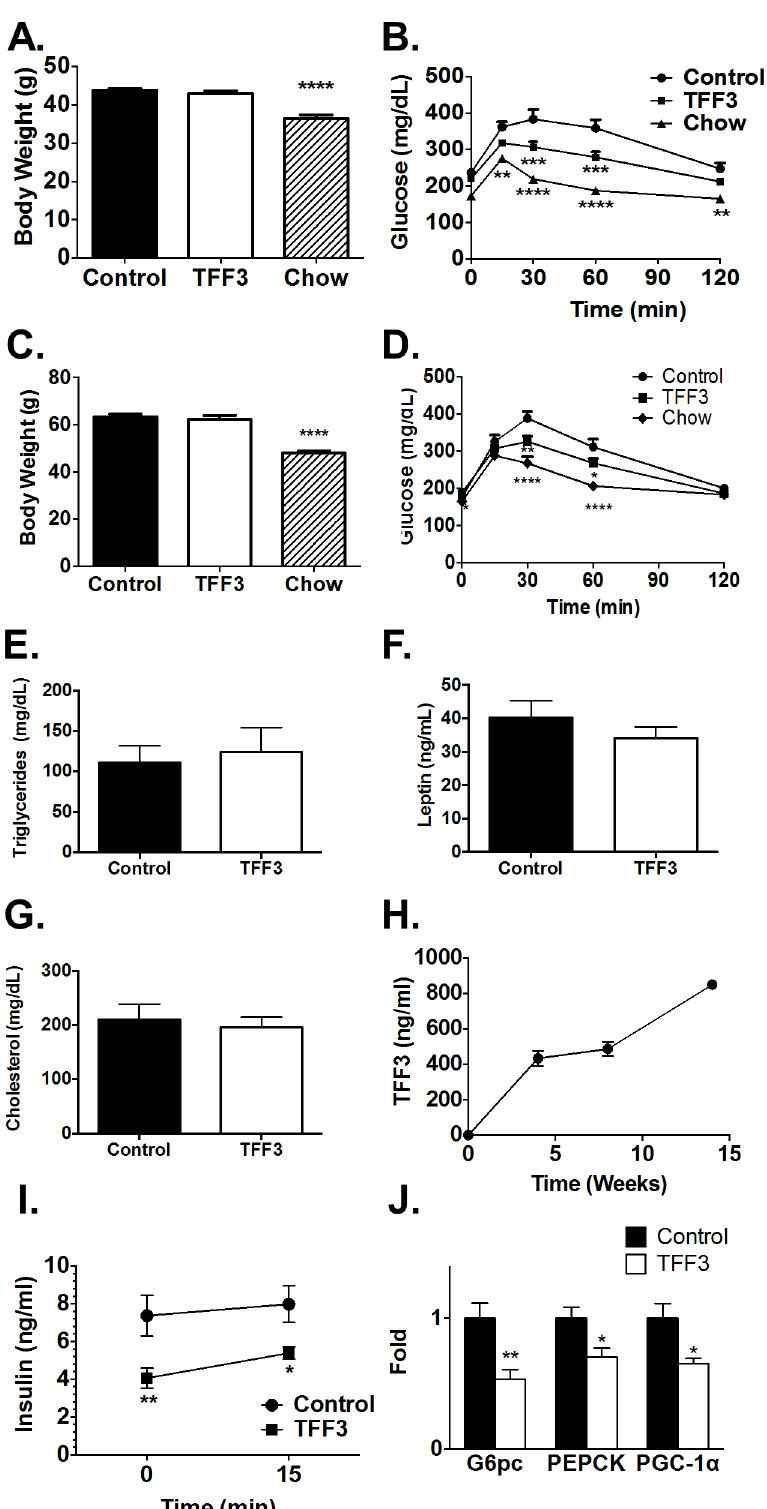
Fig 2. The effect of AAV-mediated TFF3 overexpression on the metabolic profile in BDF-DIO mice. B6D2F1 mice were maintained on high fat diet and were injected with an AAV vector containing human TFF3 cDNA (TFF3) or without inserted cDNA (Control) (n = 15/group). An additional group was returned to